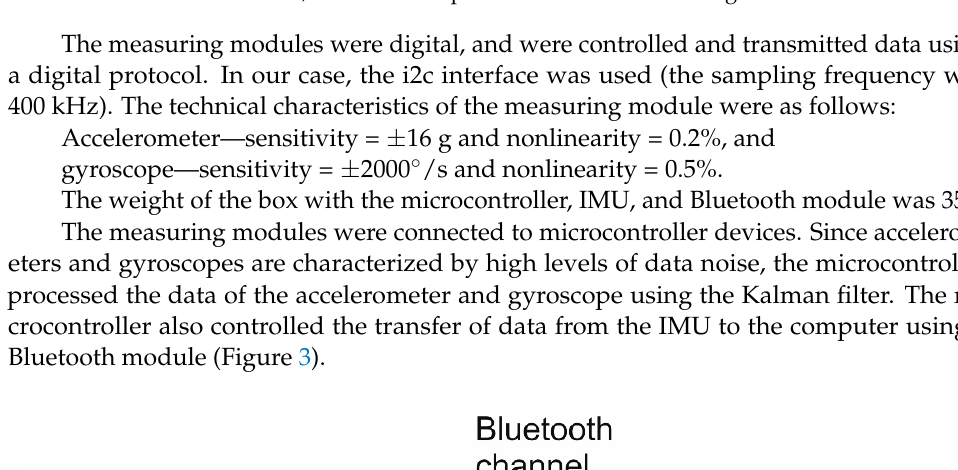
Figure 2. Hand with the inertial measurement unit (IMU) on the wrist. The positive directions of the accelerometer axes are shown, as well as the positive directions of the angular rate.